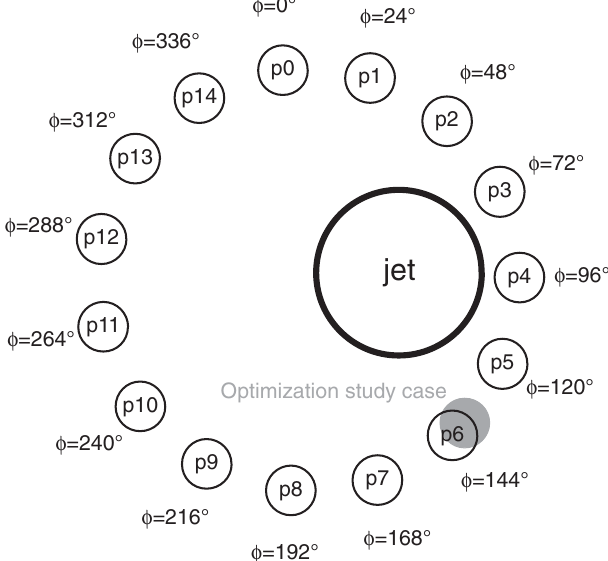
FIG. 8. The layout of multiple proton beam entry directions relative to the mercury jet at z ¼ (cid:2) 75 cm